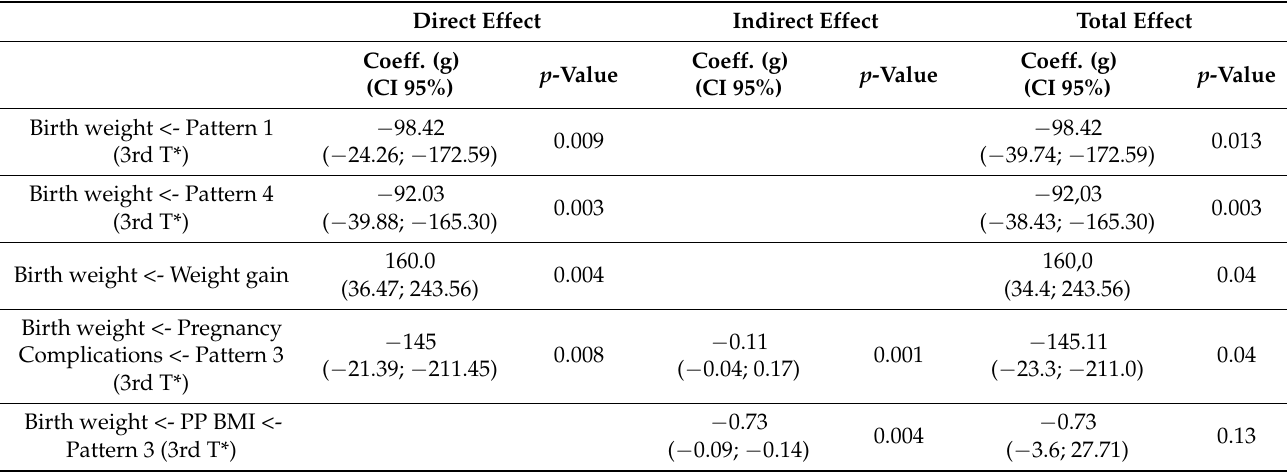
Table 3. Modelling of the structural equations to observe the direct and indirect effects between birth weight, maternal variables and dietary consumption patterns, Santo Ant ô nio de Jesus, Bahia, Brazil, 2012–2013.